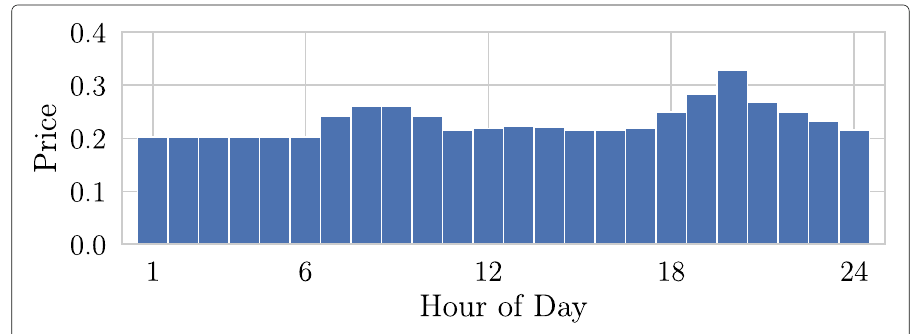
Fig. 9 Optimal pricing for a 24-hour pricing